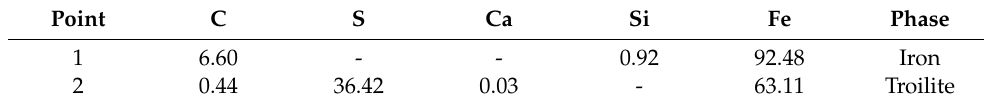
Table 7. Chemical composition of points indicated in Figure 12 (wt%).